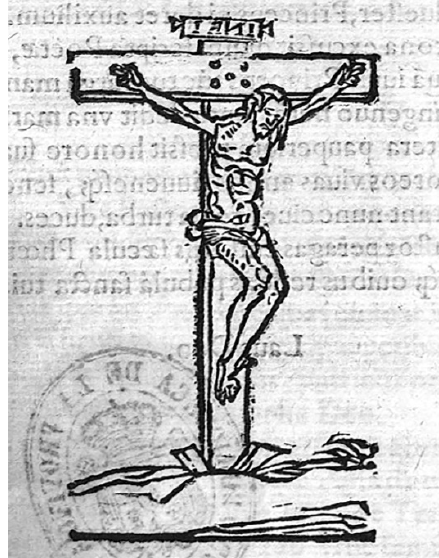
Figure 5. Anonymous. Cristo crucificado . Papal bull Licet ex debito . In Francisco de Castro: Historia de la vida y sanctas obras de Iuan de Dios … En Granada, en casa de Antonio de Librixa. Año de M.D.LXXXV, n.p.